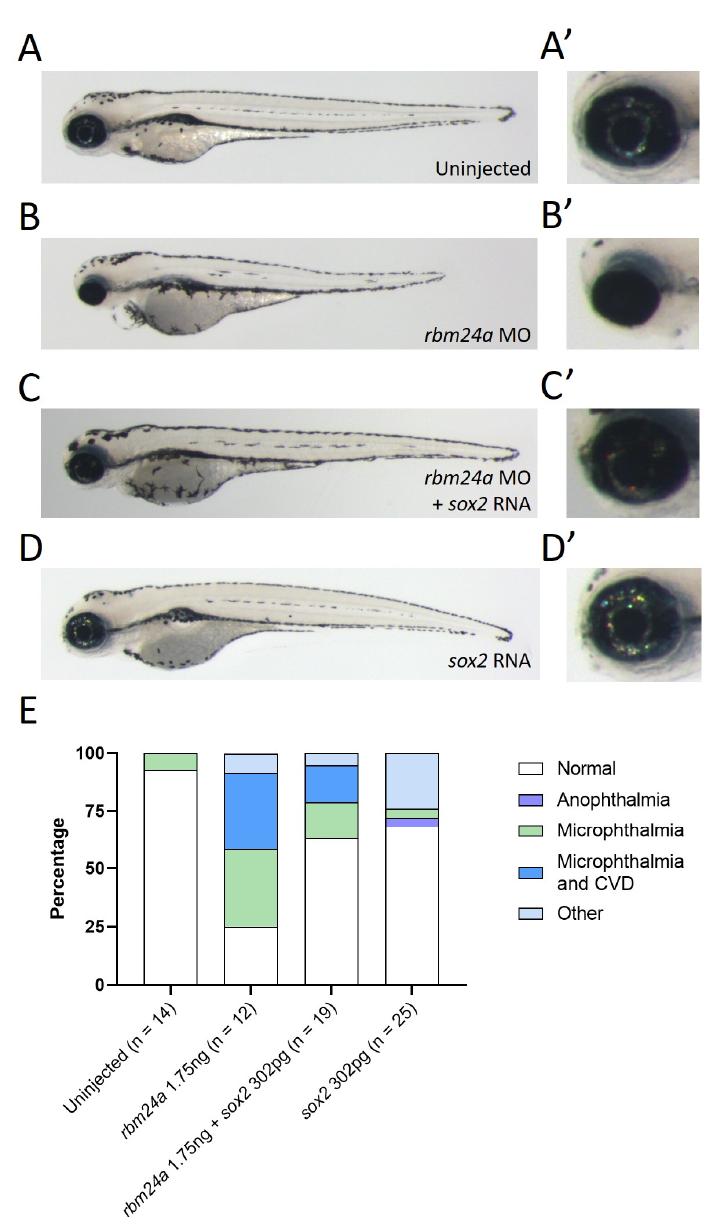
Figure 4. Exogenous sox2 can suppress rbm24a -associated microphthalmia. ( A ) Uninjected 4 dpf embryo with wild type morphology, ( A’ ) detail of eye in A. ( B ) Knockdown of rbm24a at low doses leads to microphthalmia, ( B’ ) detail of eye in B. ( C ) Sequential injection of rbm24a morpholino and sox2 RNA results in a phenotype more similar to wild type than rbm24a morphant, ( C’ ) detail of eye in C. ( D ) Injection of sox2 RNA alone results in wild type morphology, ( D’ ) detail of eye in D. ( E ) Graph of phenotypes. Images taken at 33×.